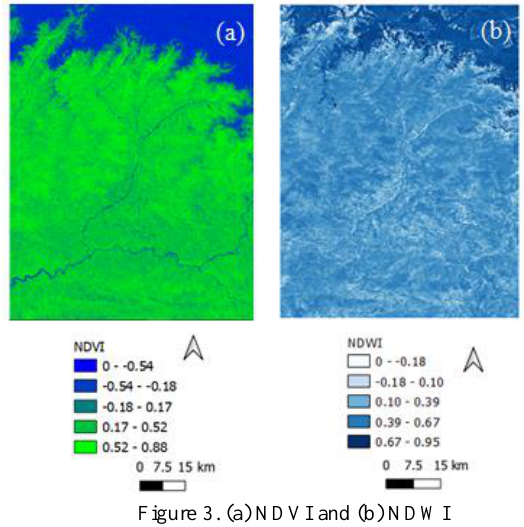
Figure 3. (a) NDVI and (b) NDWI